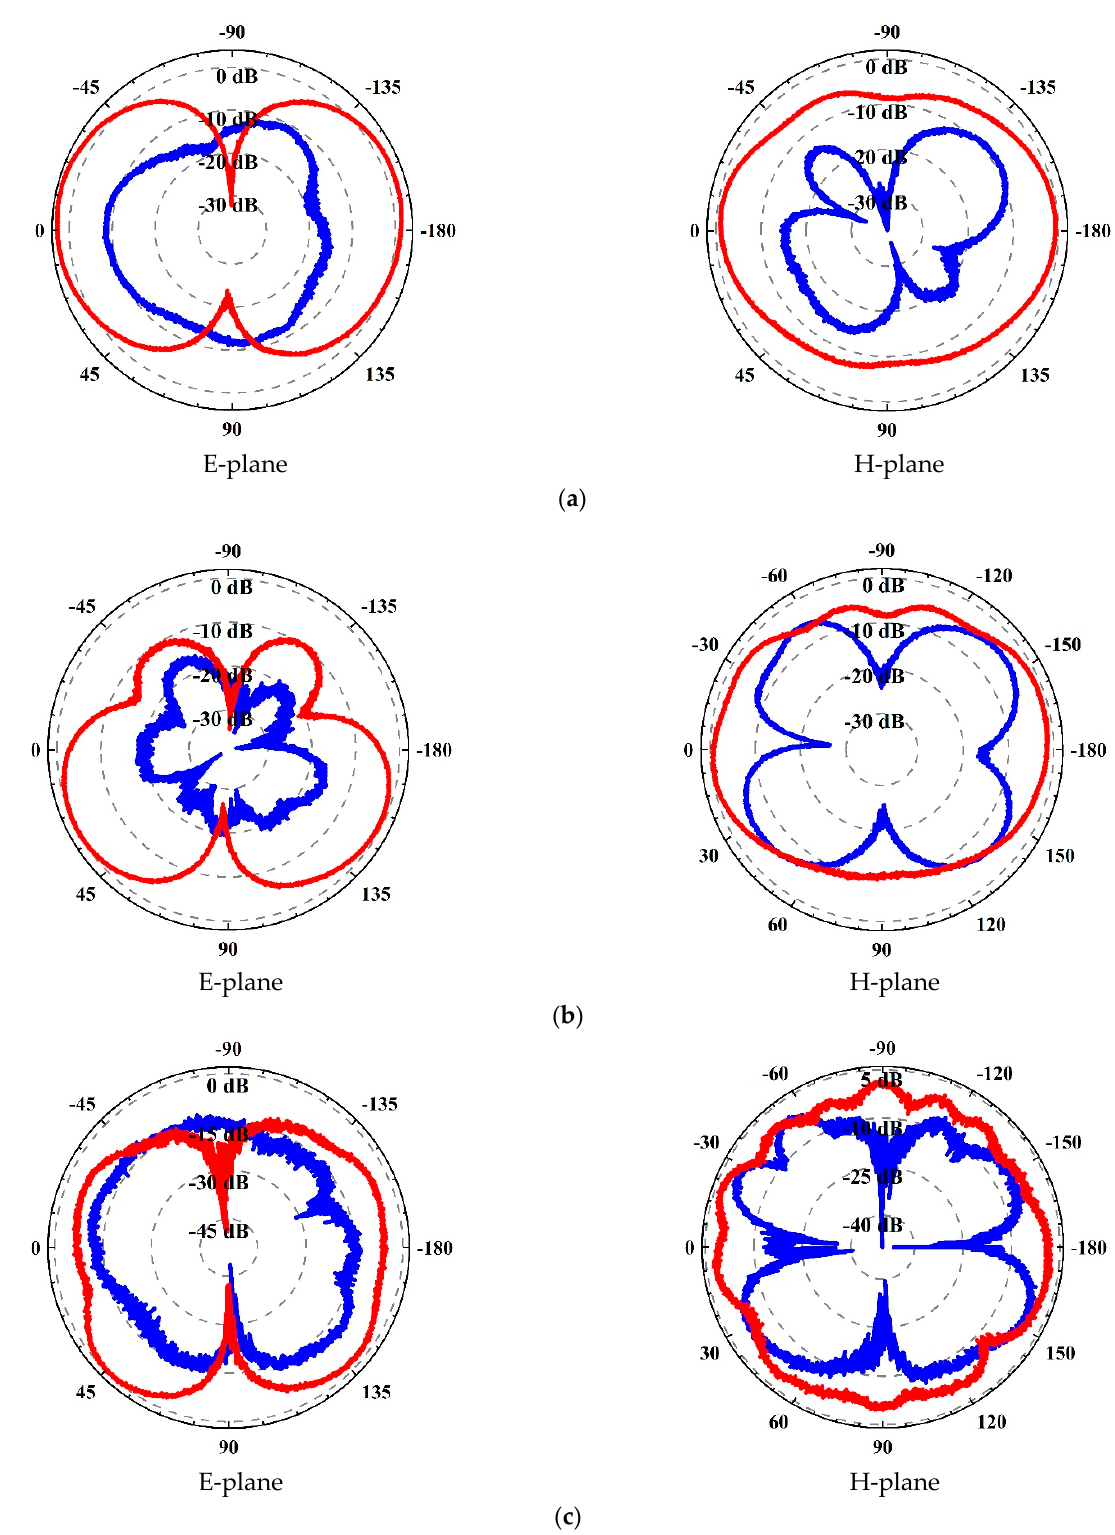
9 of 14 Figure 8. Comparison between simulated and measured results. 3.2. Measurement of Directivity and Gain The antenna is fixed in the rotating platform when measuring the directivity and gain. After calibration, the platform rotates slowly for 360 degrees and the measured re- sults are recorded at each angle. The measured normalized E-plane and H-plane radiation patterns of the antenna are shown in Figure 9. When the frequency is at 2 GHz, the direc- tion of the maximum gain is 0° and 180°. As the frequency increases, the direction of the maximum gain gradually changes, which is caused by different matching characteristics. Meanwhile, the cross-polarized radiation of the antenna is at least 10 dB weaker than the